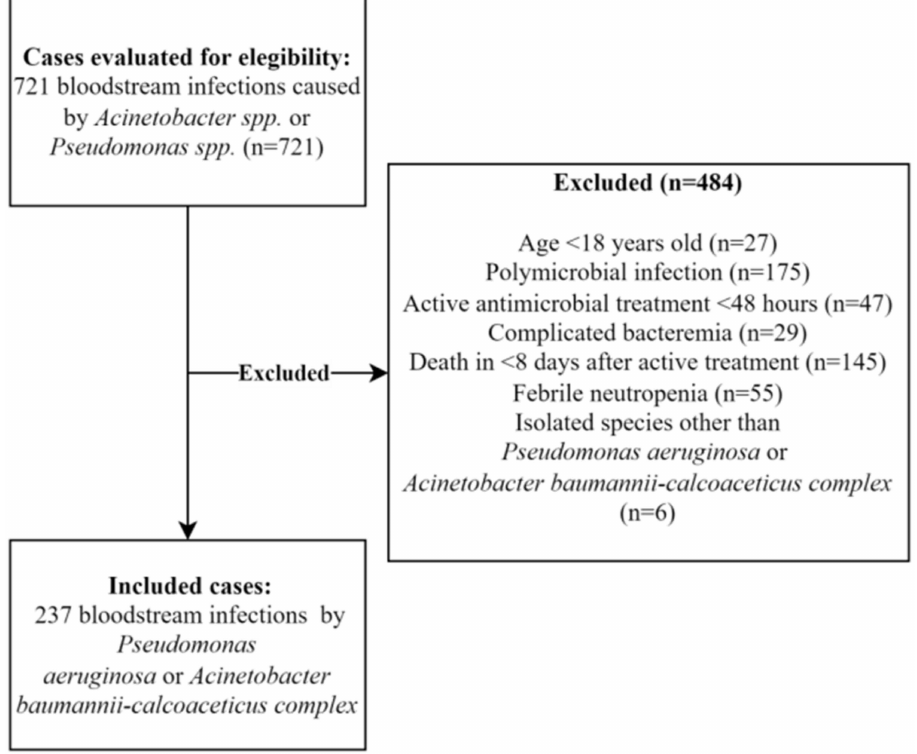
Figure 1. Study inclusion